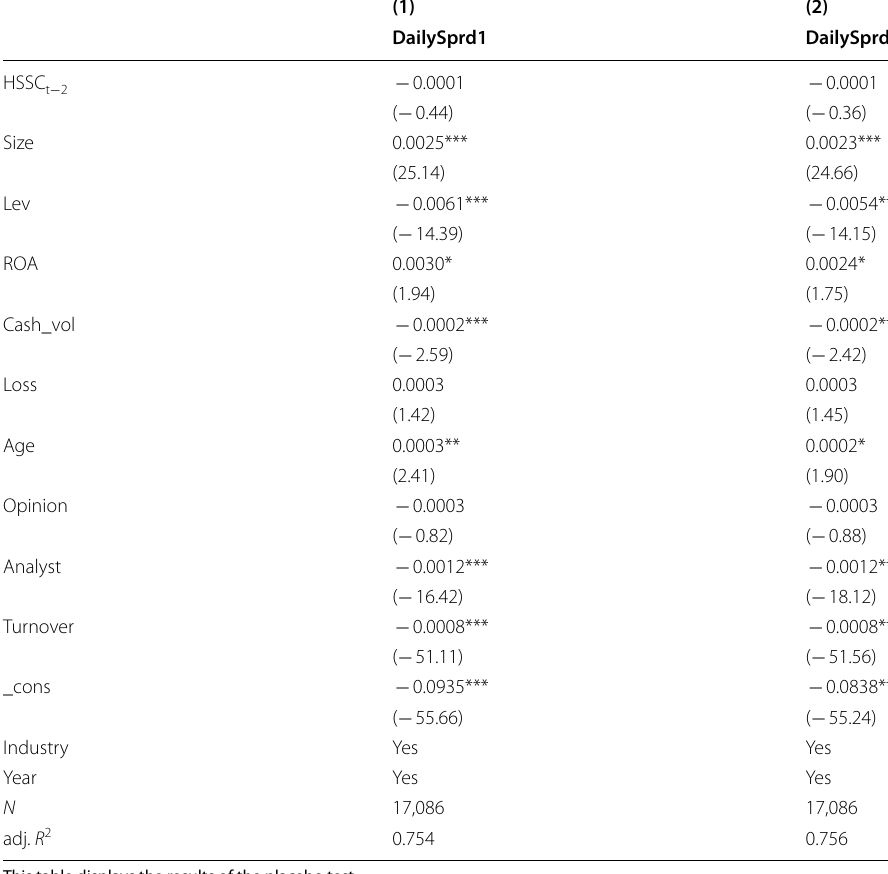
Table 7 Robustness checks: Placebo